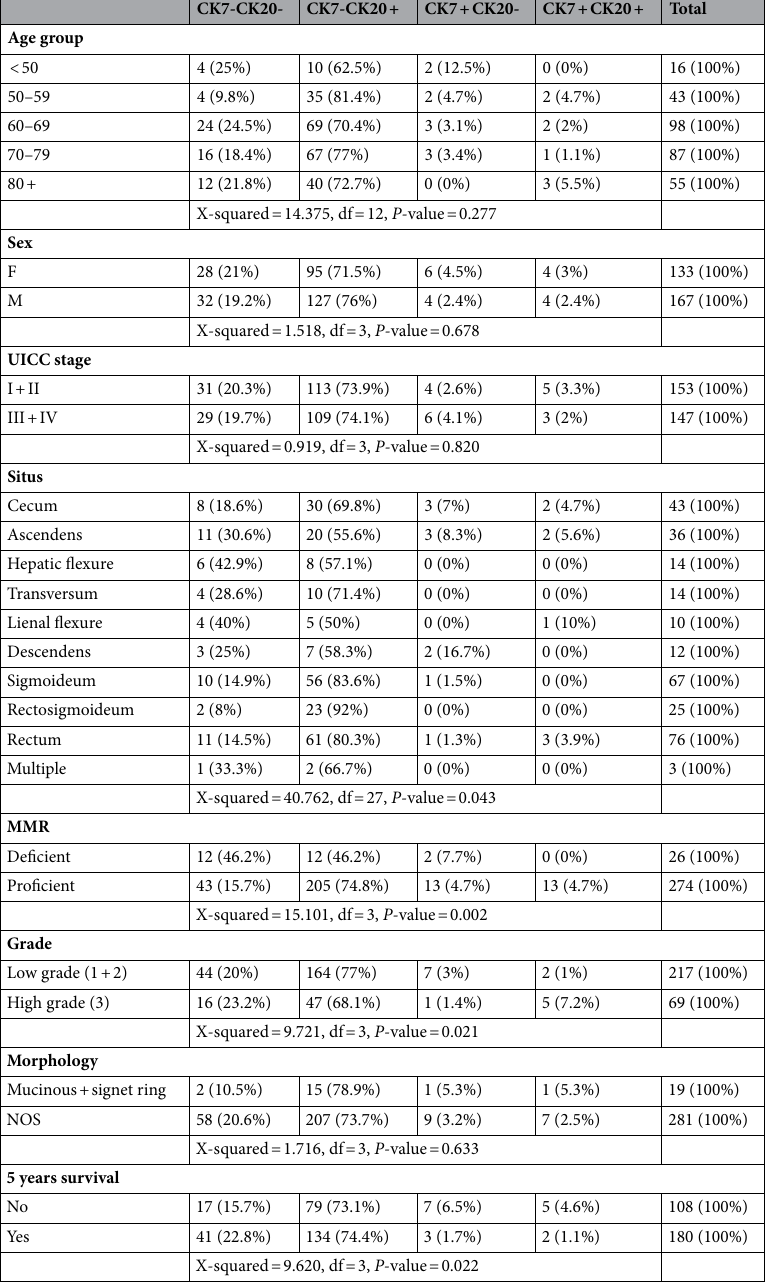
Table 1. Summarizing of the distribution of CRCs according the cytokeratin profile and all studied variables; including p values of X-square